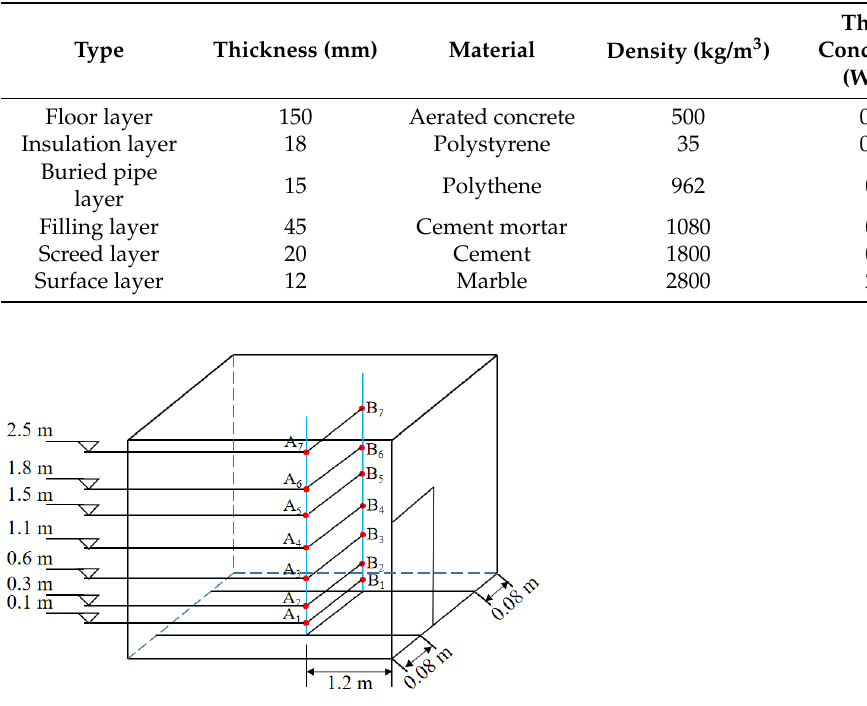
Figure 2. Radiant floor structure. Table 2. Thermal parameters of the radiant floor.